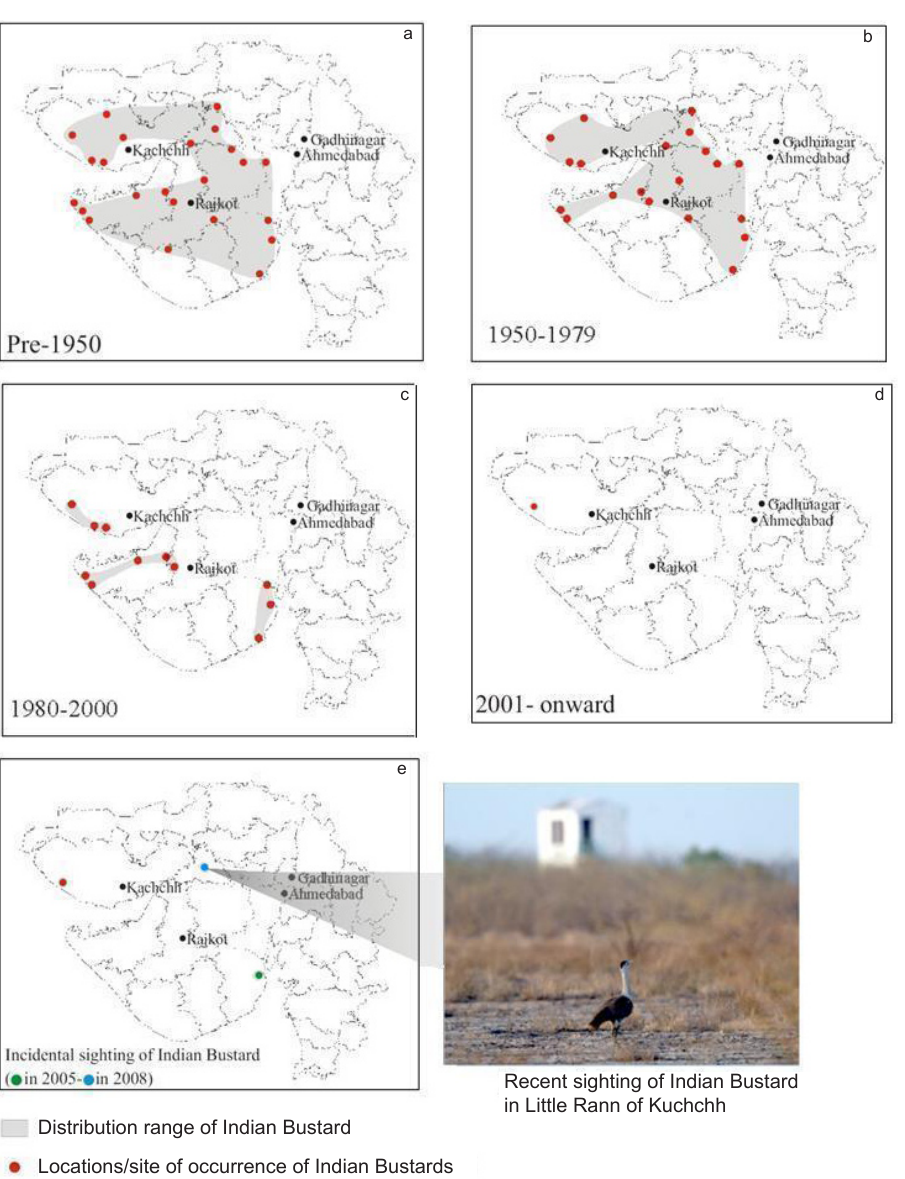
Figure 3. Shrinking of distribution range of Indian Bustard in Gujarat. Maps adapted from 3(a) - Dharmakumarsinhiji (1957); 3(b) - Rahmani & Manakadan (1990); 3(c) - Rahmani & Manakadan (1990) and Rahmani (2001); Incidental sightings of the species of 2005 and 2008 have not been shown in the map which indicates 3(d) - distribution from 2001 onwards; 3(e) - Based on present study and